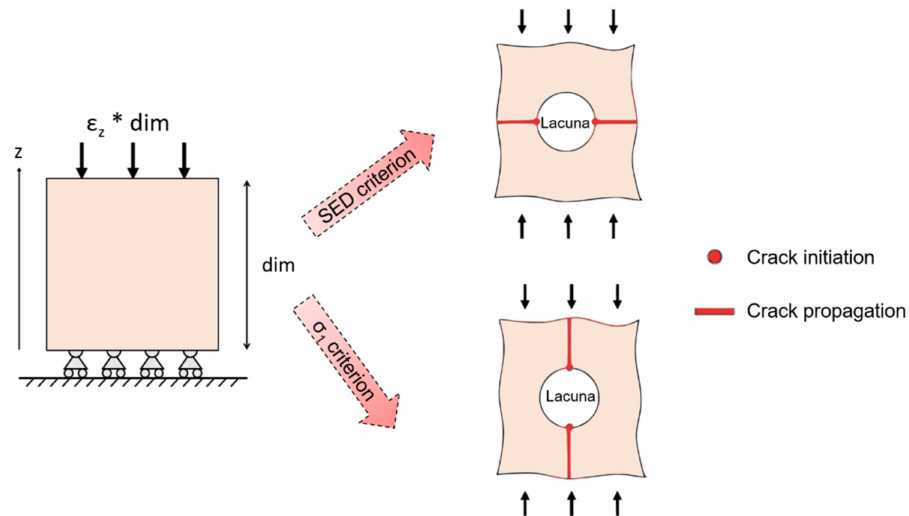
Figure 10. Schematic output of models of a bone sample with a lacuna subjected to compression. Crack initiation (dots) and crack propagation (lines) are highlighted, according to strain energy density (SED) damage criterion and to σ 1